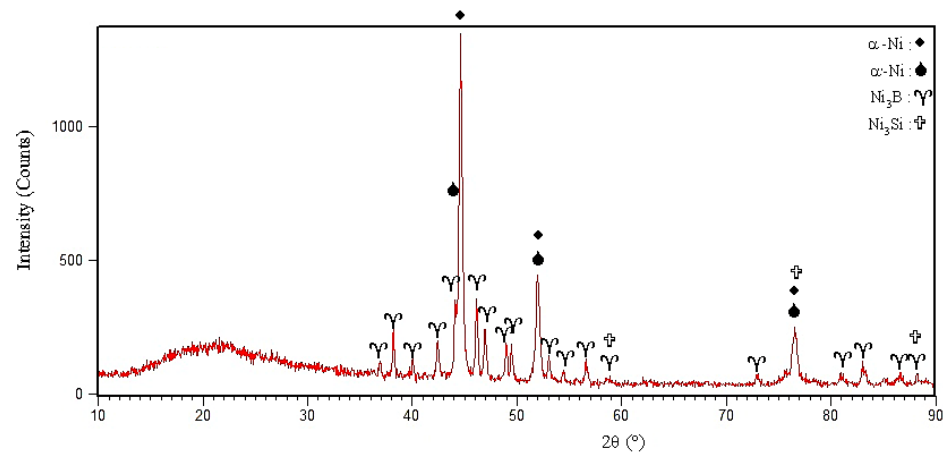
Figure 5. XRD phase analysis of the BNi-3 interlayer after annealing at 620 °C/10 min.